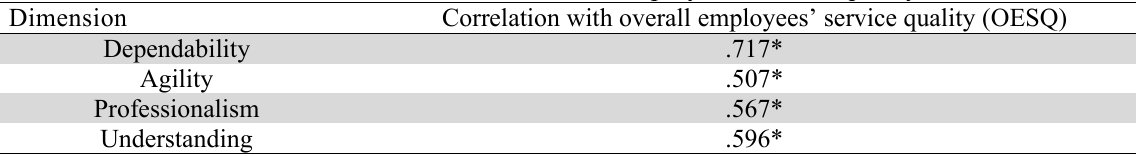
Results of correlation between dimensions and overall employees’ service quality Dimension Correlation with overall employees’ service quality (OESQ)